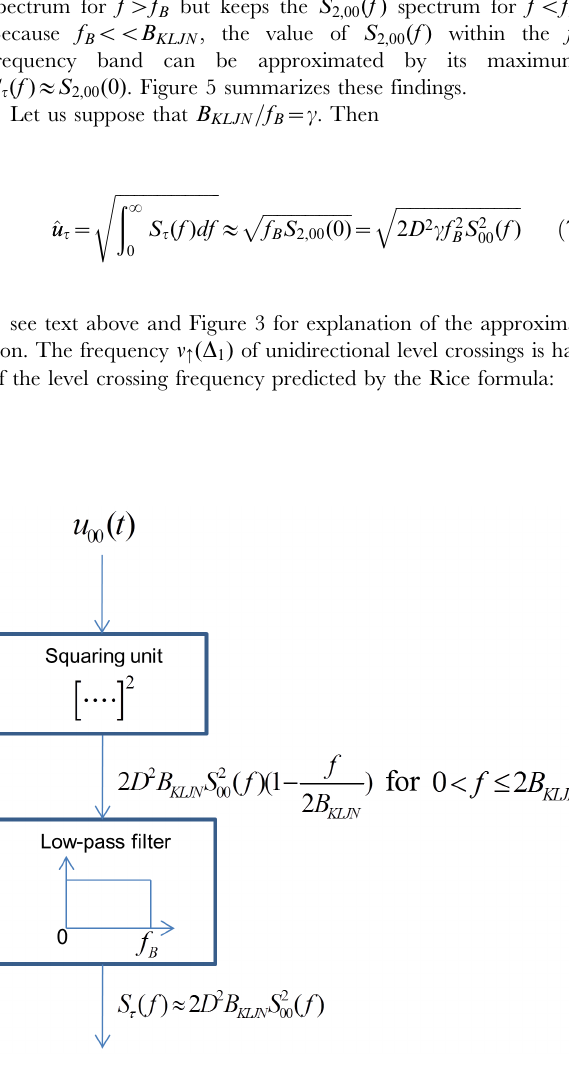
Figure 5. Spectra at the 00 bit situation. The low-pass filtering effect of the time averaging cuts off this spectrum for f w f B but keeps the S 2,00 ( f ) spectrum for f v f B . Since f vv B KLJN , the value of S 2,00 ( f ) within the frequency band f B can be approximated by its maximum, so that S t ( f ) & S 2,00 (0) ~ 2 D 2 B KLJN S 2 ( f ) . ( t ) . 00 00